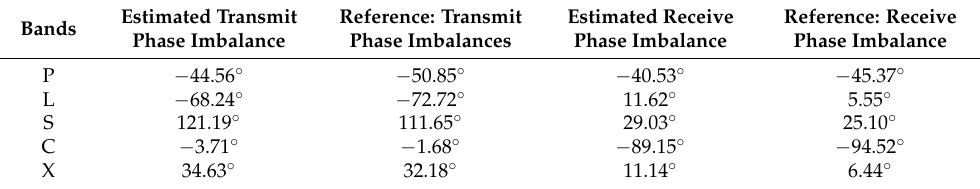
Table 2. The phase imbalances estimation results of each band ’s SAR data.